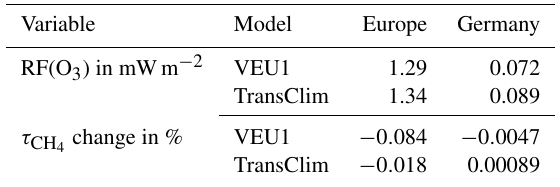
Table 5. Ozone radiative forcing (RF(O 3 )) and CH 4 lifetime ( τ CH change for the simulations derived in VEU1 (Hendricks et al., 2018) and computed by TransClim for the year 2030. The column “Eu- rope” shows the results for the European road traffic emissions, and the column “Germany” describes the values for the German road traffic